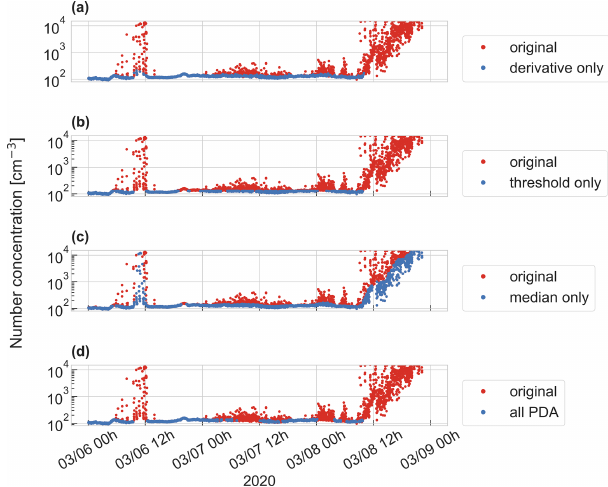
Figure B1. Intercomparison of individual filtering steps in a case study of 6 to 8 March. Clean data (in blue) are overlaid over the original data (in red) after the application of one filtering step in- dividually to the data: the (a) derivative filter, (b) threshold filter, (c) median filter, and (d) all filtering steps of the PDA were ap- plied. For all plots we used data from the CPC3025 at 1min time resolution. Original data have only been pre-cleaned for zero filter measurements.